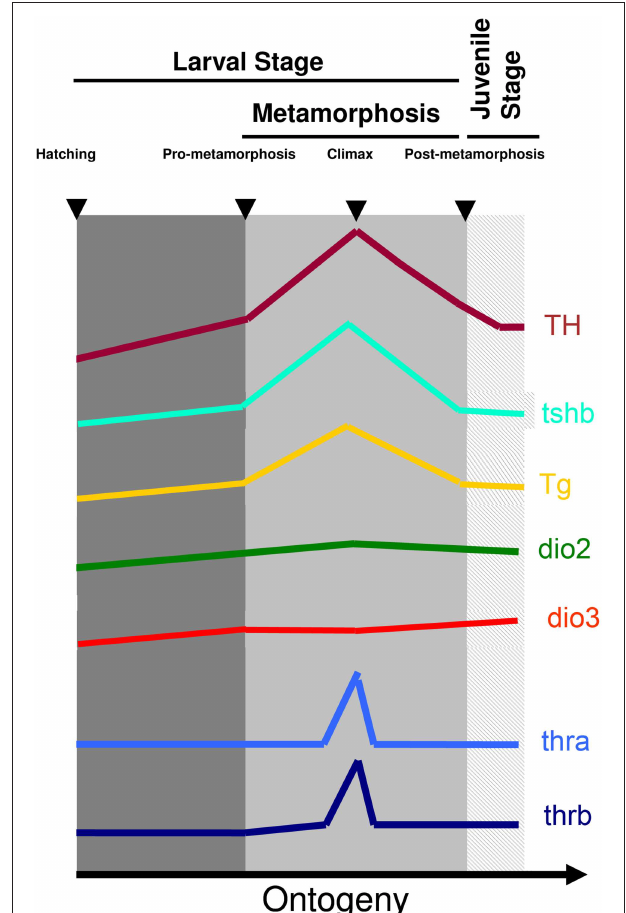
FIGURE 1 | Archetypal profile of T4 and T3 and expression of tshb , tg , dio2 , dio3 , thra, and thrb genes during teleost metamorphosis. The general observation in teleost species so far indicates that a surge of TH is accompanied by a rise in tshb and tg expression and the increased expression of TH signaling genes dio2 and thyroid hormone receptors together with a decrease of dio3 . As soon as metamorphosis terminates TH levels decrease concomitantly with decreased levels of expression of tshb and tg and dio2 and thyroid hormone receptors , whereas dio3 levels increase to pre-metamorphic levels. Figure adapted from ( 15) with permission from